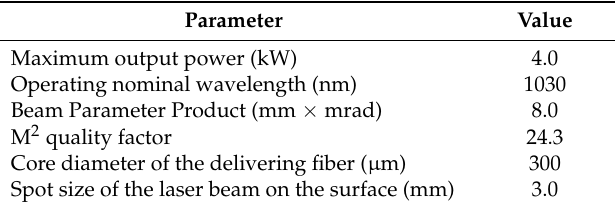
Table 2. Main technical features of the laser source.